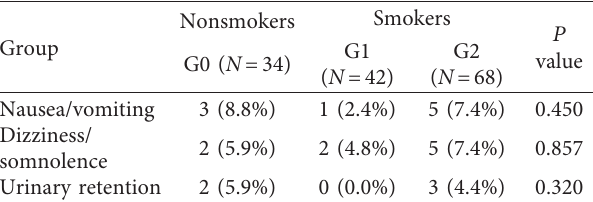
Table 3: Opioid side effects up to postoperative day